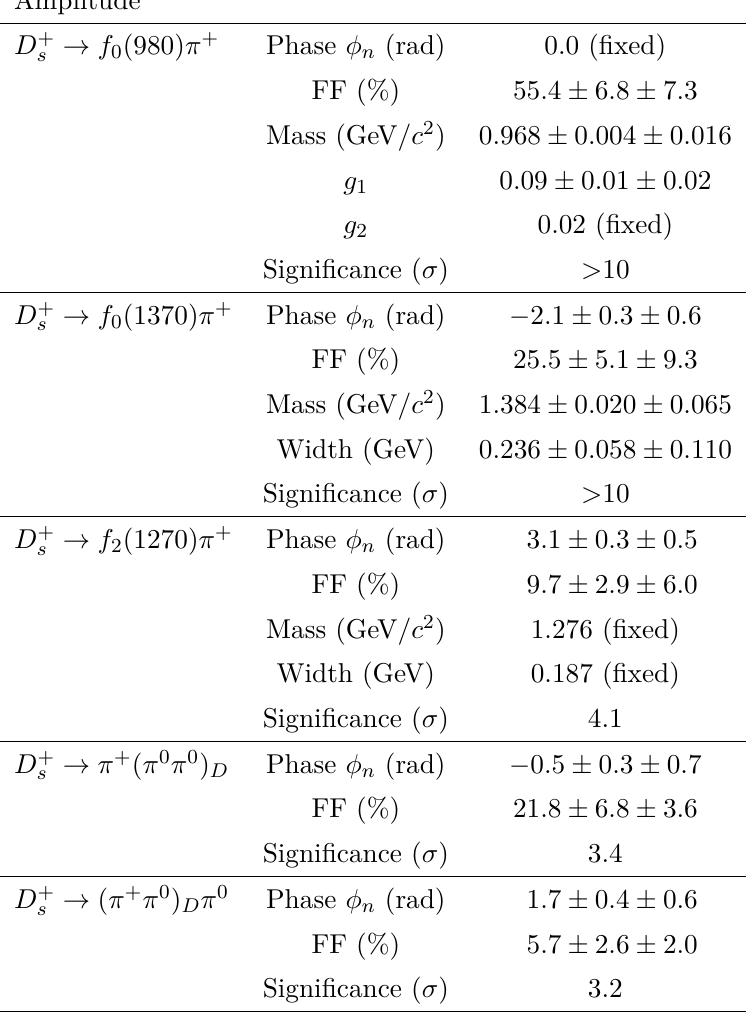
Table 3 . The phases, FFs, and statistical significances ( σ ) for the amplitudes, and the parameters of resonances. The first and the second uncertainties in the phases and FFs are statistical and systematic, respectively. The total FF is 118.0 % .